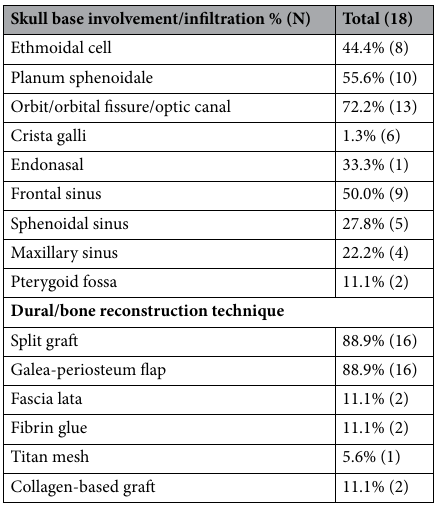
Table 2. Skull base tumor infiltration and performed reconstruction